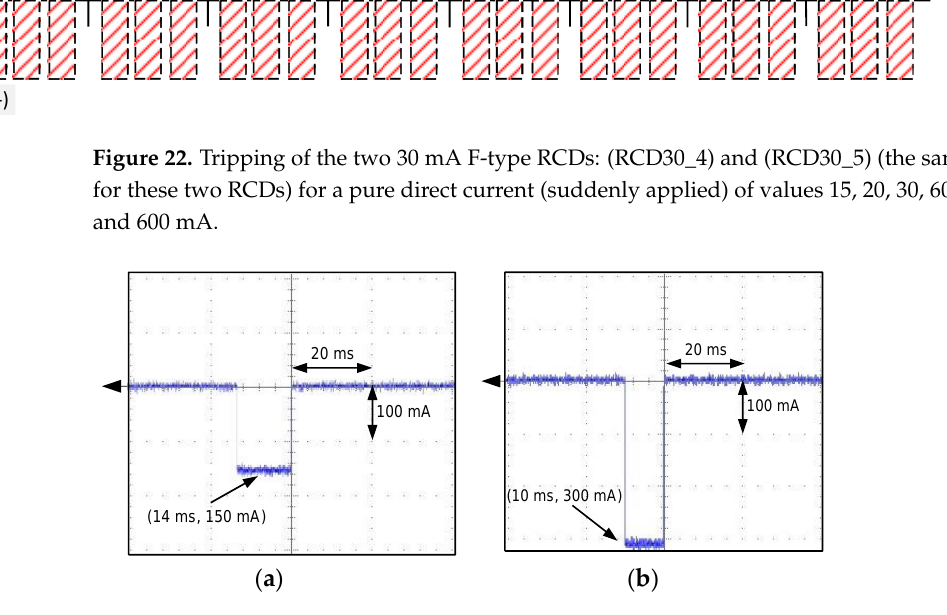
Figure 23. Oscillograms of the DC current flow during the tripping test of the A-type RCD (RCD30_6). Suddenly applied DC current of the following values: ( a ) 150 mA; ( b ) 300 mA.